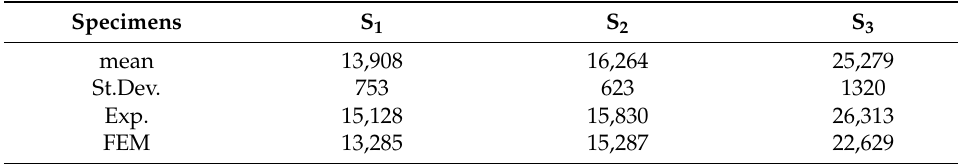
Table 3. Statistical parameters of the estimated failure load